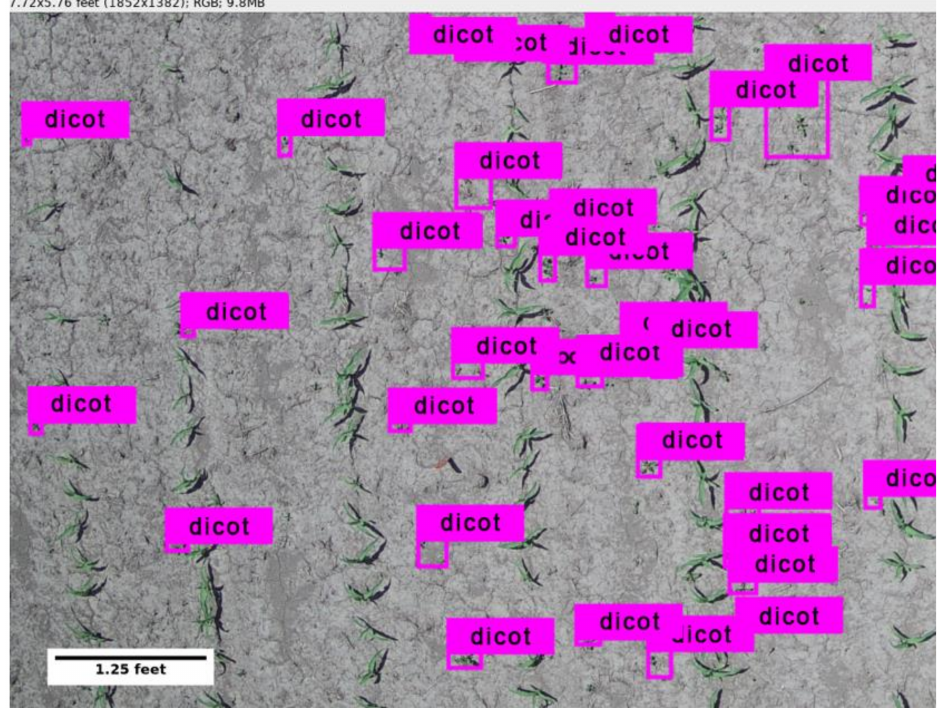
Figure 10. Dicot detection test set result from the YOLOv3 training on Image Set